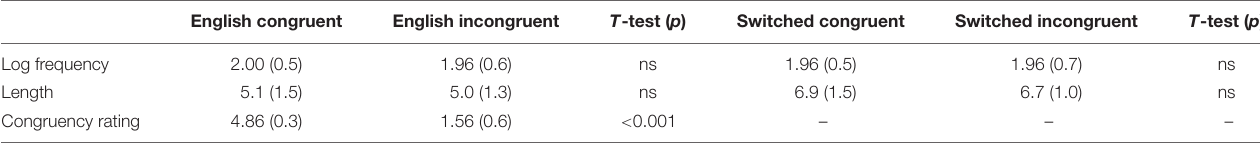
TABLE 2 | Descriptive statistics on experimental variables, including log frequency, length and congruency ratings.